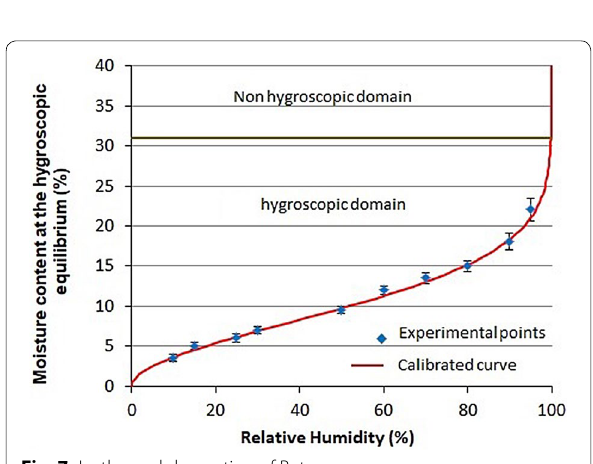
Fig. 7 Isothermal desorption of